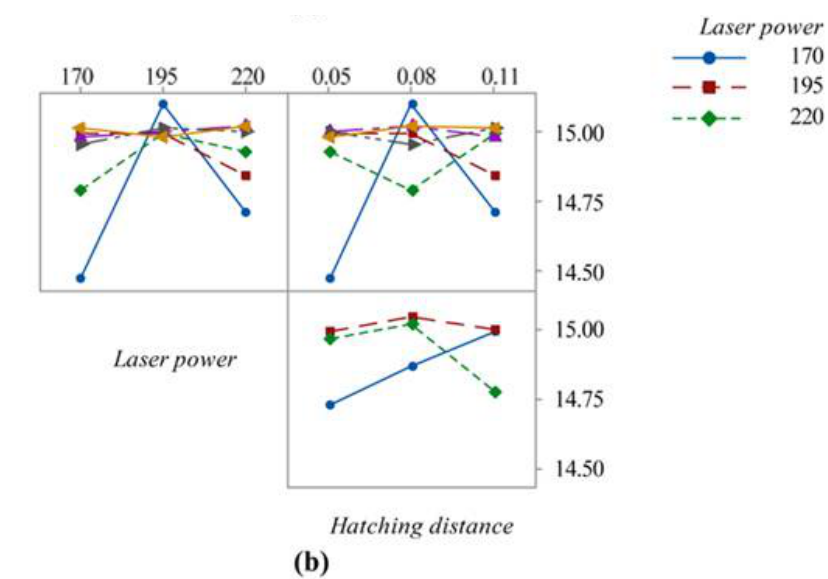
Figure 10. Interaction plot between process parameters and accuracy: ( a ) x-direction, ( b ) y-direc- tion.